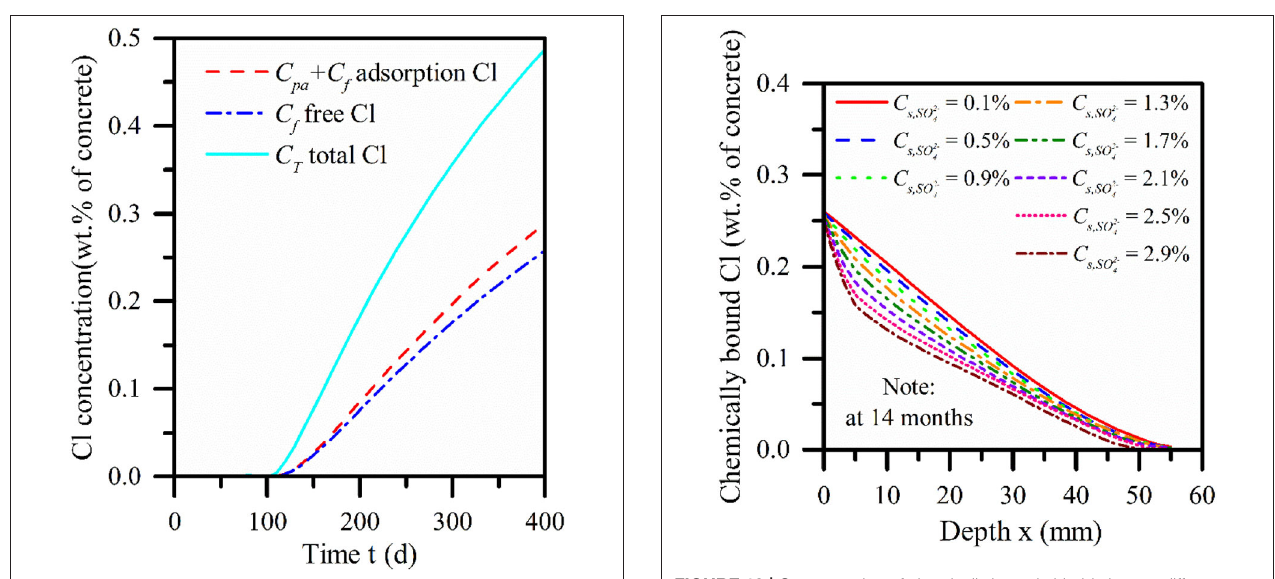
FIGURE 8 | Three forms of concrete interior calculated by model: the free chloride, the chloride of including the physical adsorption and the total chloride.